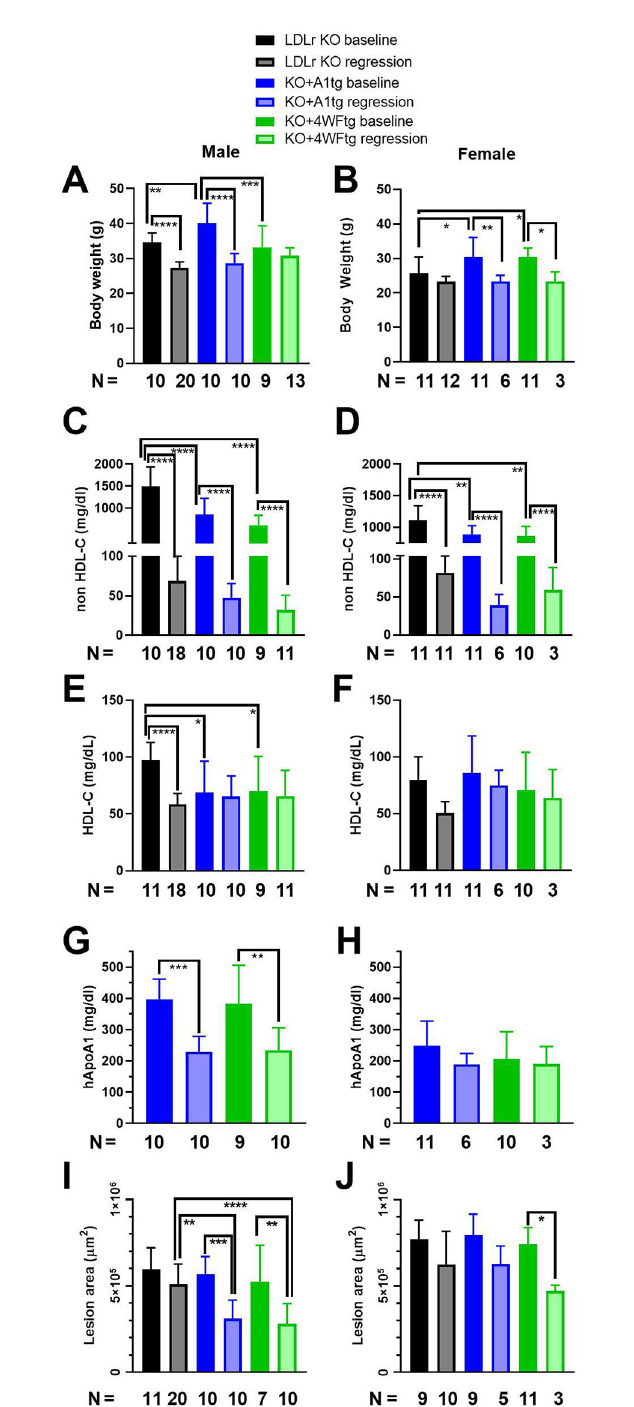
Fig 2. Lesion regression (unsaturated colors) from baseline (saturated colors) in male (left side) and female (right side) mice. A,B . Body weights at baseline and after seven weeks on the regression diet. C,D . Non-HDL-C levels. E,F . HDL-C levels. G,H . human apoA1 levels. I,J . Aortic root lesion areas. For all panels, black bars are LDLr KO mice, blue bars are LDLr KO expressing the wild type human apoA1 transgene, and green bars are LDLr KO expressing the 4WF human apoA1 transgene. Mean ± SD with the number of mice for each column at the bottom; ANOVA Tukey posttest p-values: � , p < 0.05; �� , p < 0.01; ��� , p < 0.001; and ���� . p < 0.0001. The N under the bars represents the number of mice used for each measurement. The numbers may vary if insufficient plasma was obtained for cholesterol measurements or the aortic root lesion sectioning was not perpendicular to the aortic root.